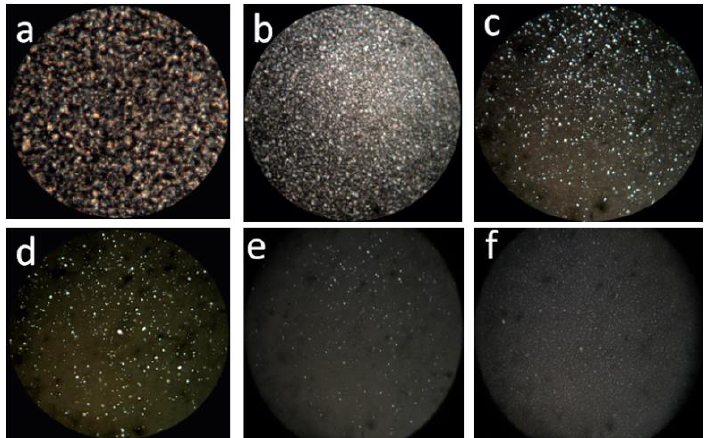
Figure 9. Spherulite morphology of ( a ) virgin PP, ( b – f ) PP-H25 nanocomposites containing 1, 2, 3, 4 and 5 wt% GNPs respectively at 130 °C and 10× magnification.